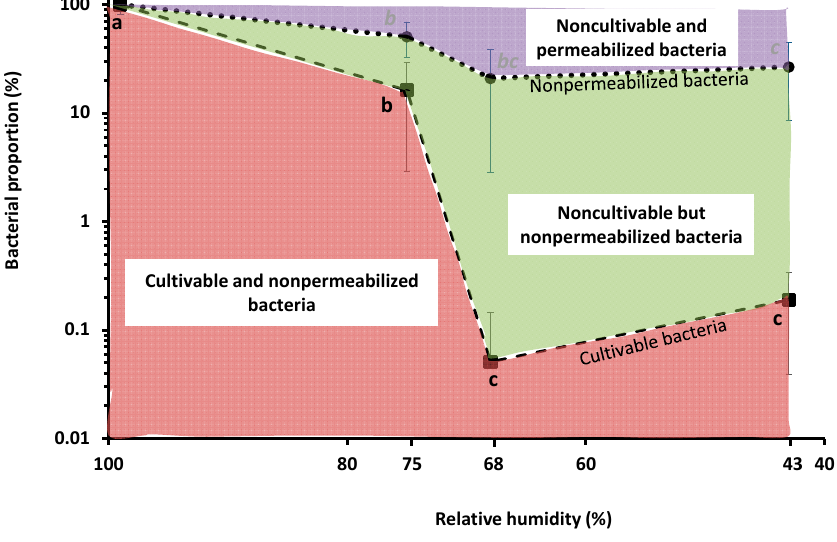
Figure 1. Impact of drying in PBS on L. monocytogenes EGDe cultivability and plasma membrane permeability. Bacteria were dried at 75%, 68% or 43% RH for 3 h at 25 ◦ C, then instantaneously rehydrated in PBS. Undried bacteria were maintained at 99% RH (control). ( - - - ) represents the proportion of cultivable bacteria and ( • • • ) the proportion of nonpermeabilized bacteria. The proportion of cultivable bacteria was estimated using the CFU counting method, the proportion of nonpermeabilized bacteria was estimated by labelling cells with PI and using a flow cytometer. Letters indicate significant differences ( p < 0.05) based on Tukey post hoc tests. Two independent Tukey tests were run: one for cultivability measurement (black letters) and another for nonpermeabilized bacteria counting (italics grey